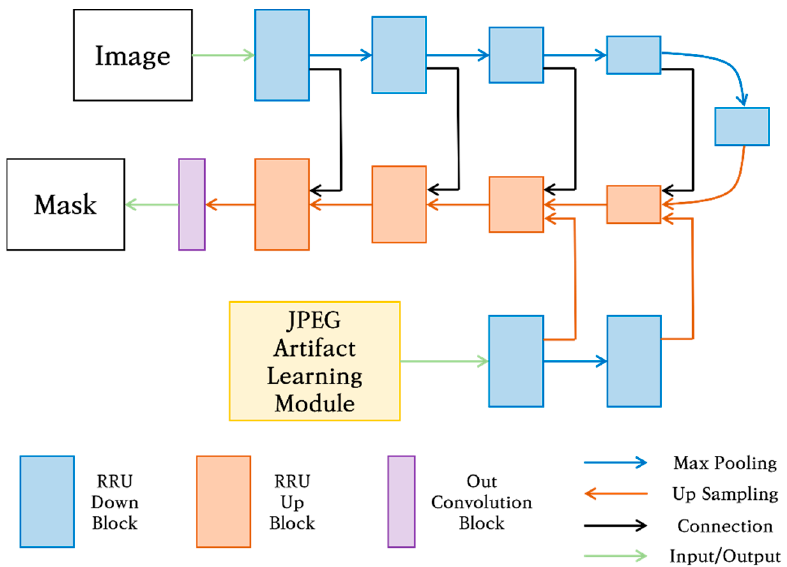
Figure 2. DRRU-Net Architecture.